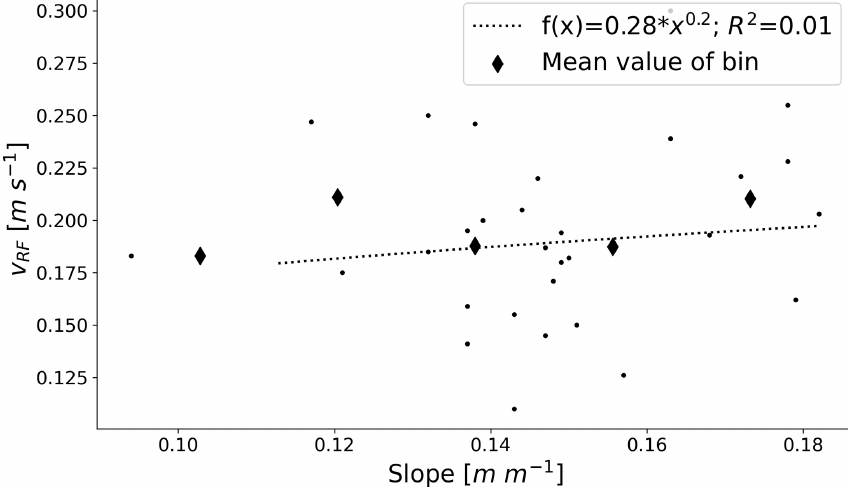
Figure B4. Slope of experiment plots vs. rill flow velocity.